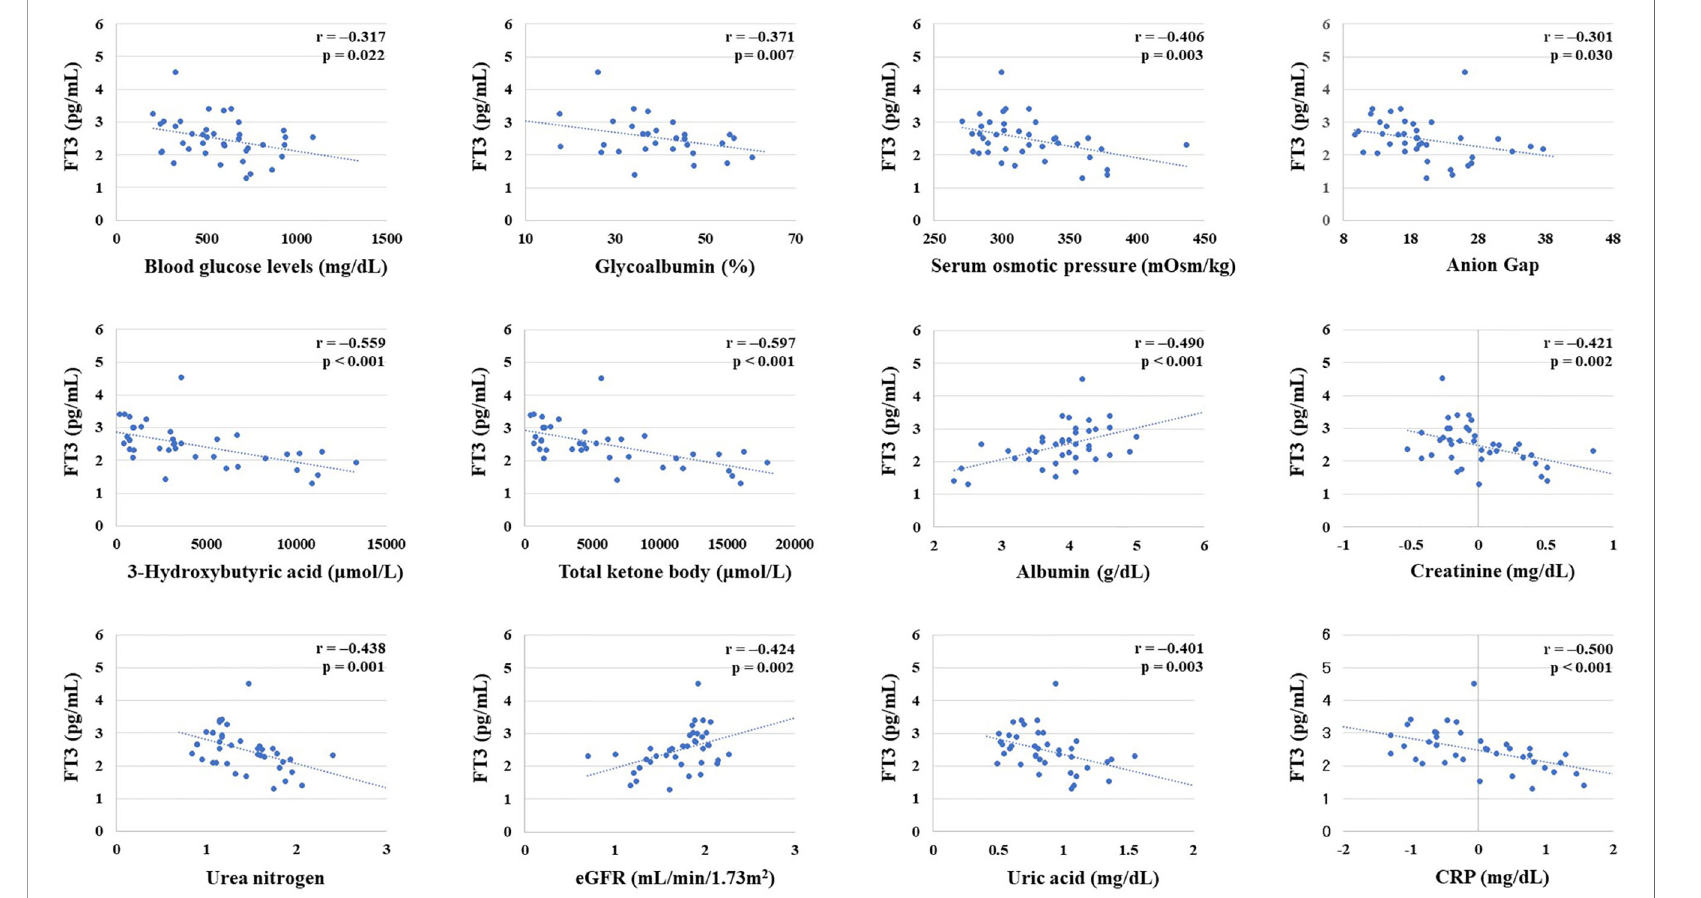
FIGURE 2 | Correlation between free thyroxine 3 (FT3) level and various parameters. Creatinine, urea nitrogen, estimated glomerular fi ltration rate (eGFR), albumin, and CRP were converted to natural logarithm. There was a signi fi cant negative correlation between FT3 and blood glucose levels on admission, glycoalbumin, serum osmolality, Anion Gap, 3-hydroxybutyrate, total ketones, creatinine, urea nitrogen, uric acid, and CRP. There was a signi fi cant positive correlation between FT3 and albumin and